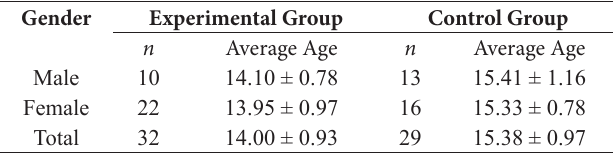
Table 1. Characteristics of the sample (gender and